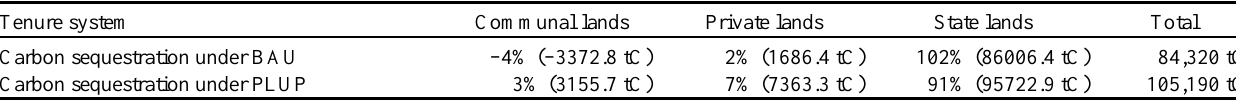
Table 3. Carbon sequestration after 10 years under different management strategies (BAU, PLUP) Tenure